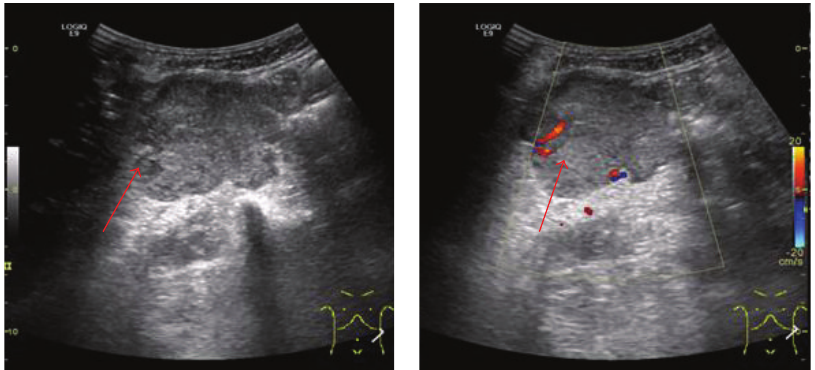
Figure 1: Ultrasound shows hypoechoic nodule in the hepatic lobe, and CDFI shows blood flow in the lesion. Lesion (red arrows) by liver puncture, which is guided by US, is proved to be